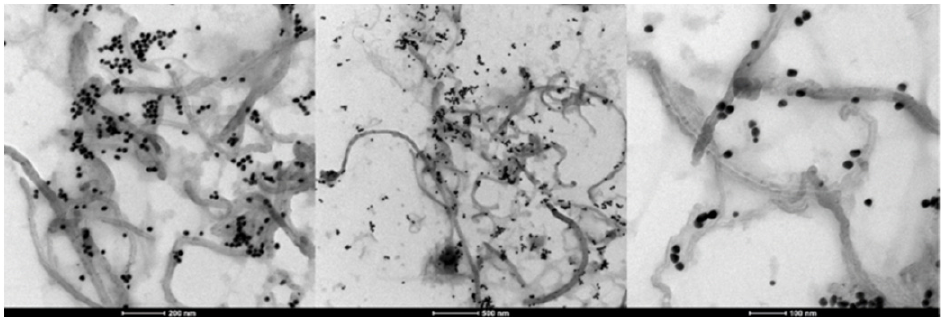
Figure 6. TEM image of Au–MWCNT hybrid nanofluid.